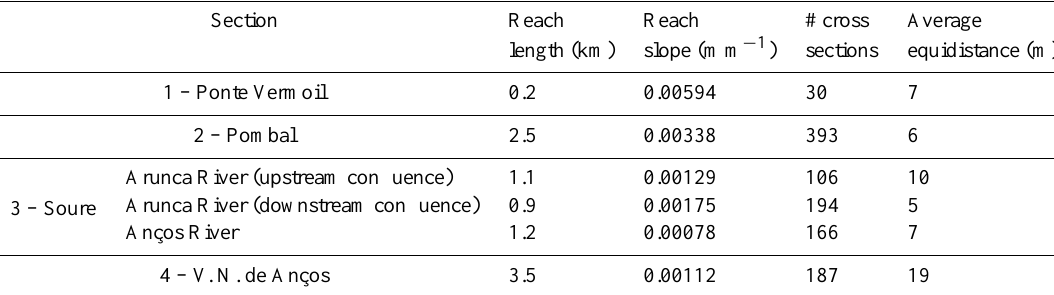
Table 4. Geometric data in the four sections applications.